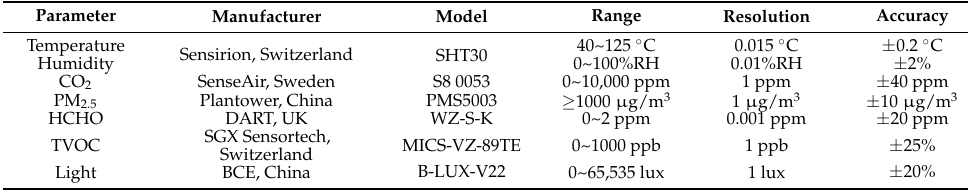
Figure 3. Environmental monitoring equipment. Table 2. Properties of environmental